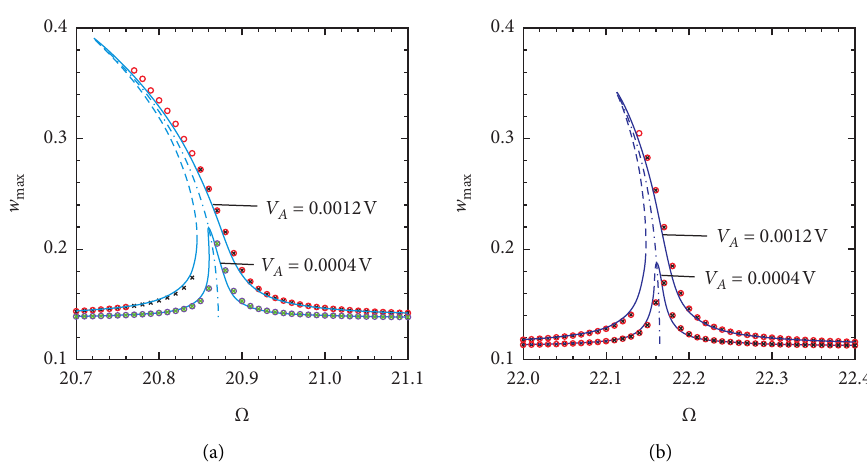
Figure 12: Amplitude-frequency curve: V